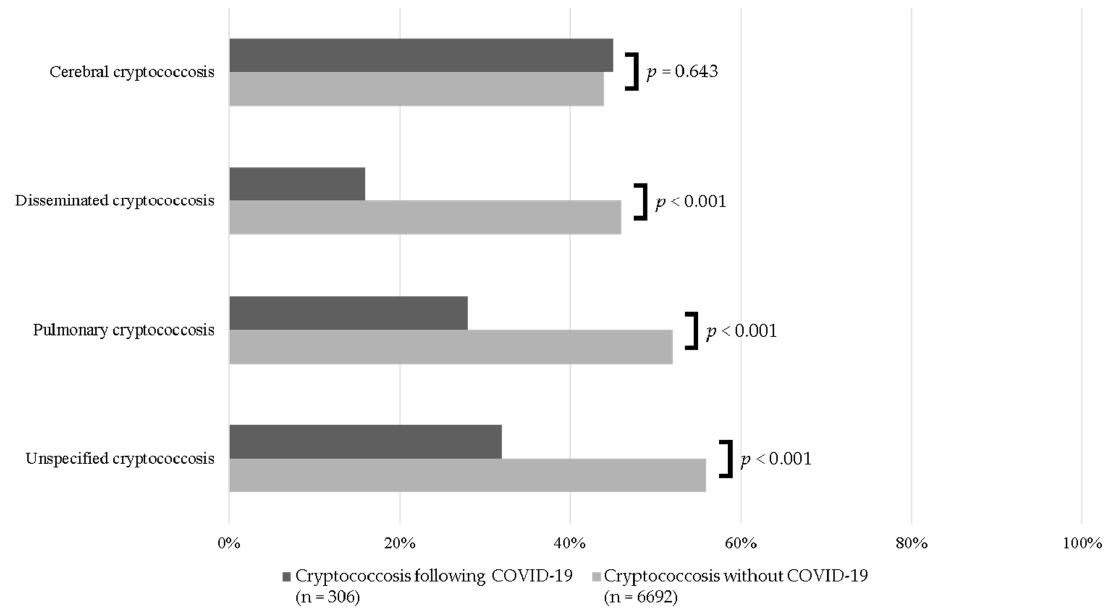
Figure 2. Types of cryptococcosis among patients with a history of COVID-19 compared to non- COVID-19 controls.